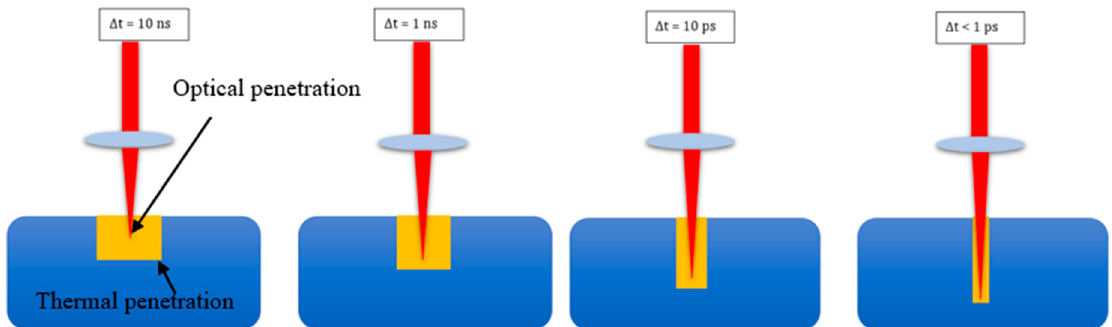
8 of 49 Figure 2. Comparison of CW, ns and fs laser material absorption processes [57]. When ultrashort pulsed lasers with high laser fluence are applied, ablation of heated matter occurs in a few tens of ps after absorption [47]. In the case of metals interacting with ultrashort lasers, the electron gas absorbs the laser and heats up in less than a hun- dred fs, whereas the lattice heats up with a delay of 1–100 ps [98,99]. Additionally, HAZ can be less than 5 µm, and for plastic materials, it can be up to 30–50 µm [47]. On the other